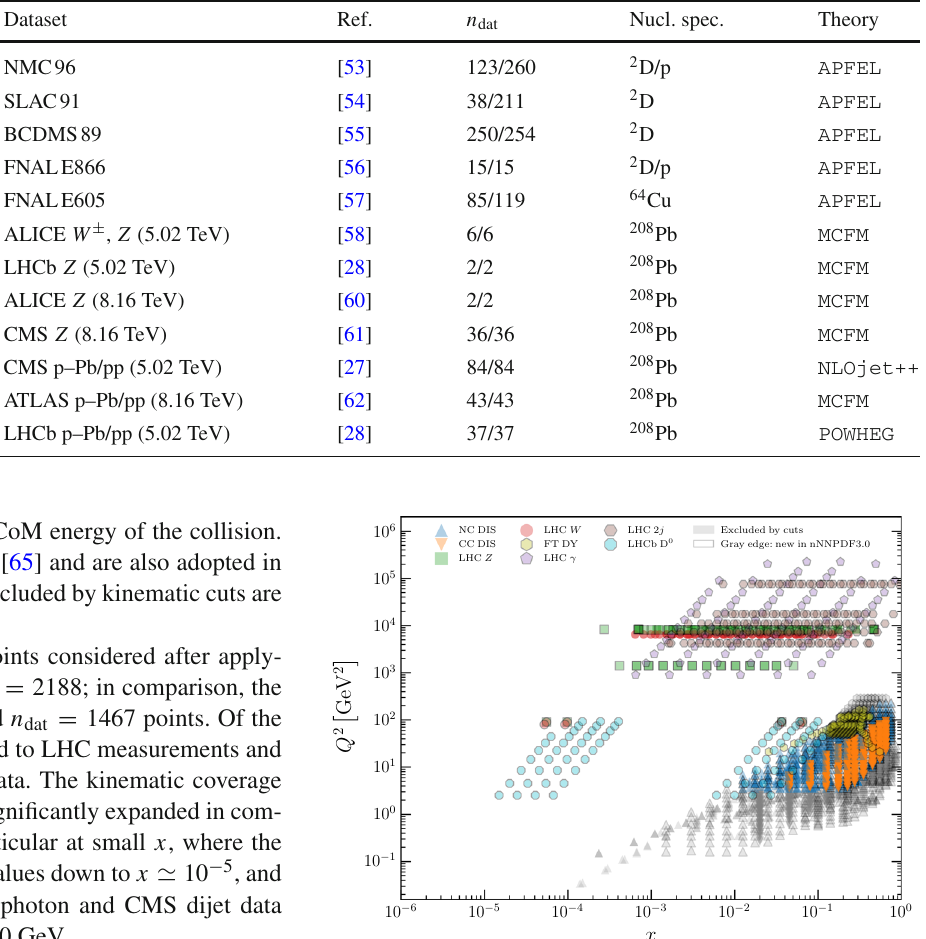
quark matching conditions. In the fit, the following input values are used: m c = 1 . 51 GeV, m b = 4 . 92 GeV, and ( M ) = 0 . 118, respectively for the charm and bottom α s Z quark masses, and for the strong coupling at a scale equal to the Z -boson mass M Z . pling, with the following input values for the on-shell gauge boson masses (widths): M W = 80 . 398 GeV ( (cid:4) W = 2 . 141 GeV) and M Z = 91 . 1876 GeV ( (cid:4) Z = 2 . 4952 GeV). The G μ scheme is used, with a value of the Fermi constant G F = 1 . 1663787 10 − 5 GeV − 2